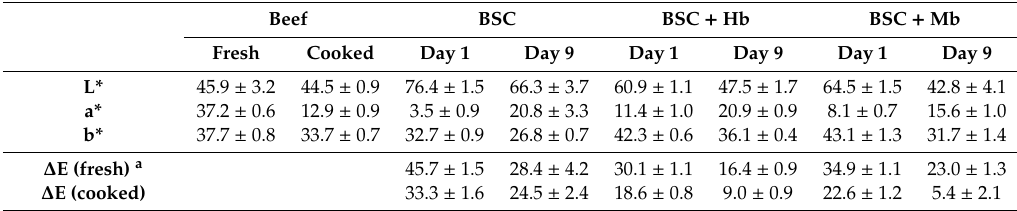
Table 1. Color of BAMs generated from BSC, BSC + Hb, or BSC + Mb (3 mg / mL for both heme proteins) after one or nine days of incubation, compared with fresh and cooked beef